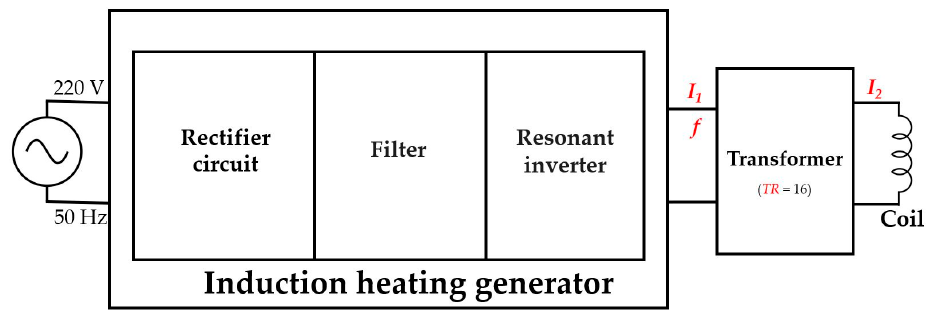
Figure 5. A diagram of an induction heating machine.